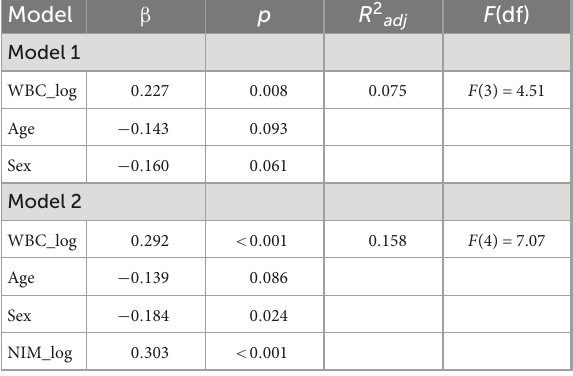
TABLE 7 Hierarchical regression models for the NIM index as predictor of LTL ( N =